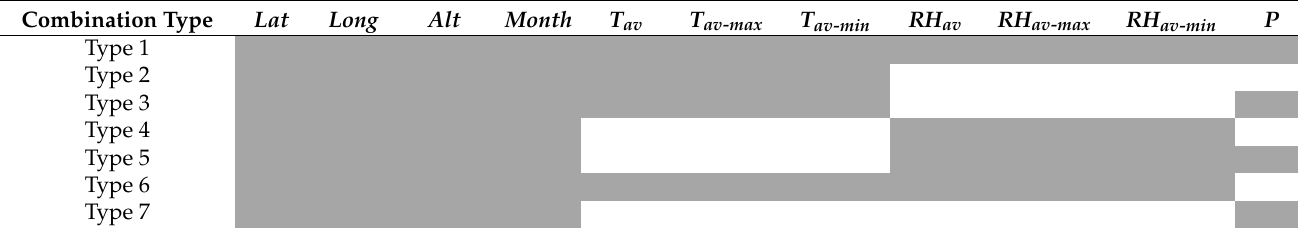
Table 1. Variables, and their combination, used to develop the different models: (i) latitude ( Lat ), (ii) longitude ( Long ), (iii) altitude ( Alt ), (iv) month, (v-vii) average ( T av ), average of the maximum ( T av-max ) and the average of the minimum temperature ( T av-min ); (viii-xi) average ( RH av ), an average of the maximum ( RH av-max ) and the average of the minimum ( RH av-min ) relative humidity and (xii) precipitation ( P ).